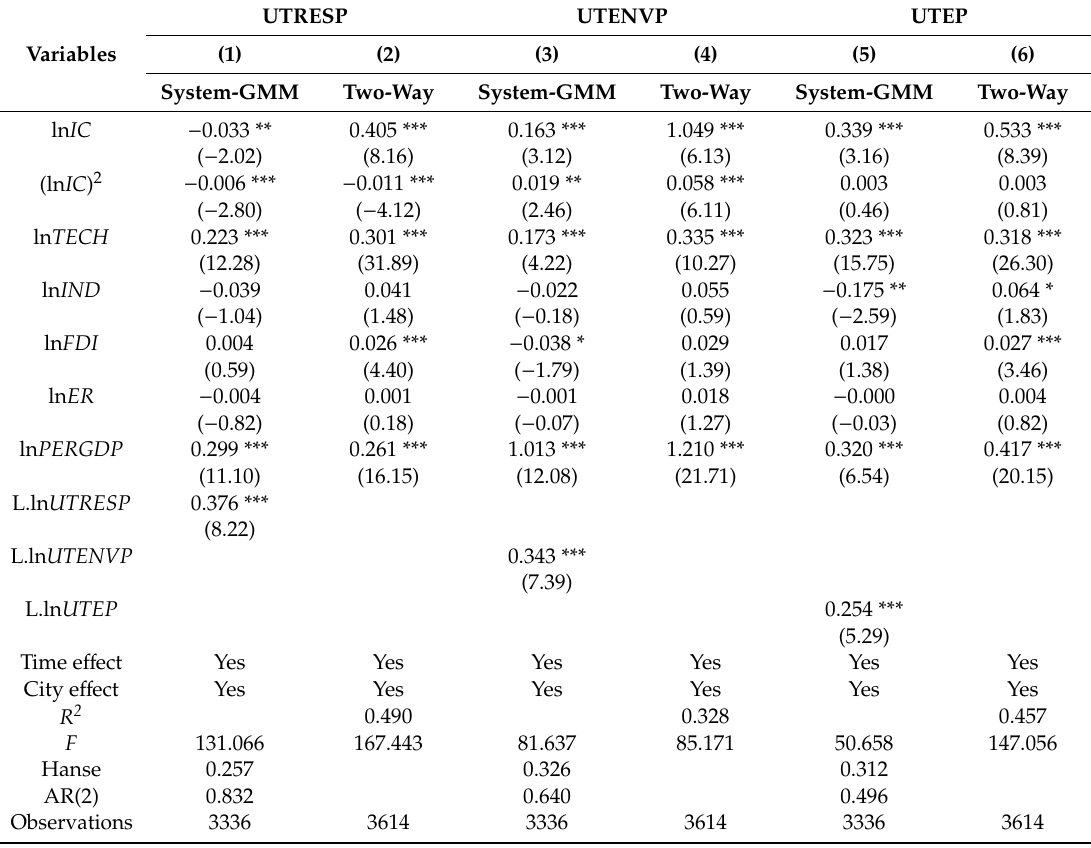
Table 3. Basic estimated